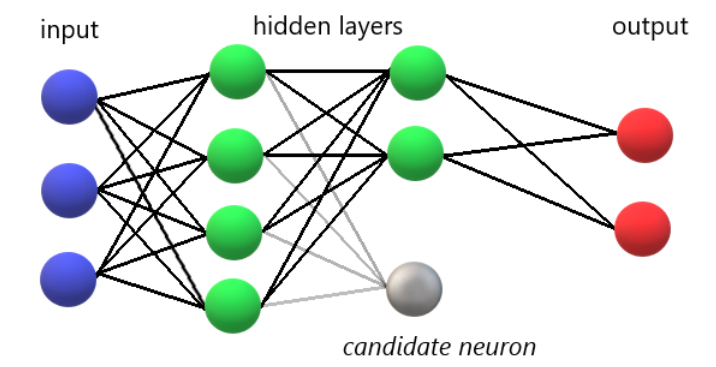
Figure 3. Candidate neuron at neural